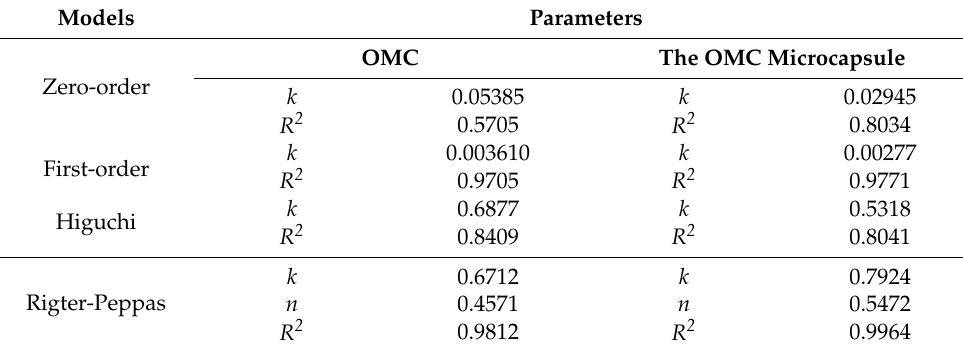
Table 5. Kinetic models for the OMC microcapsule